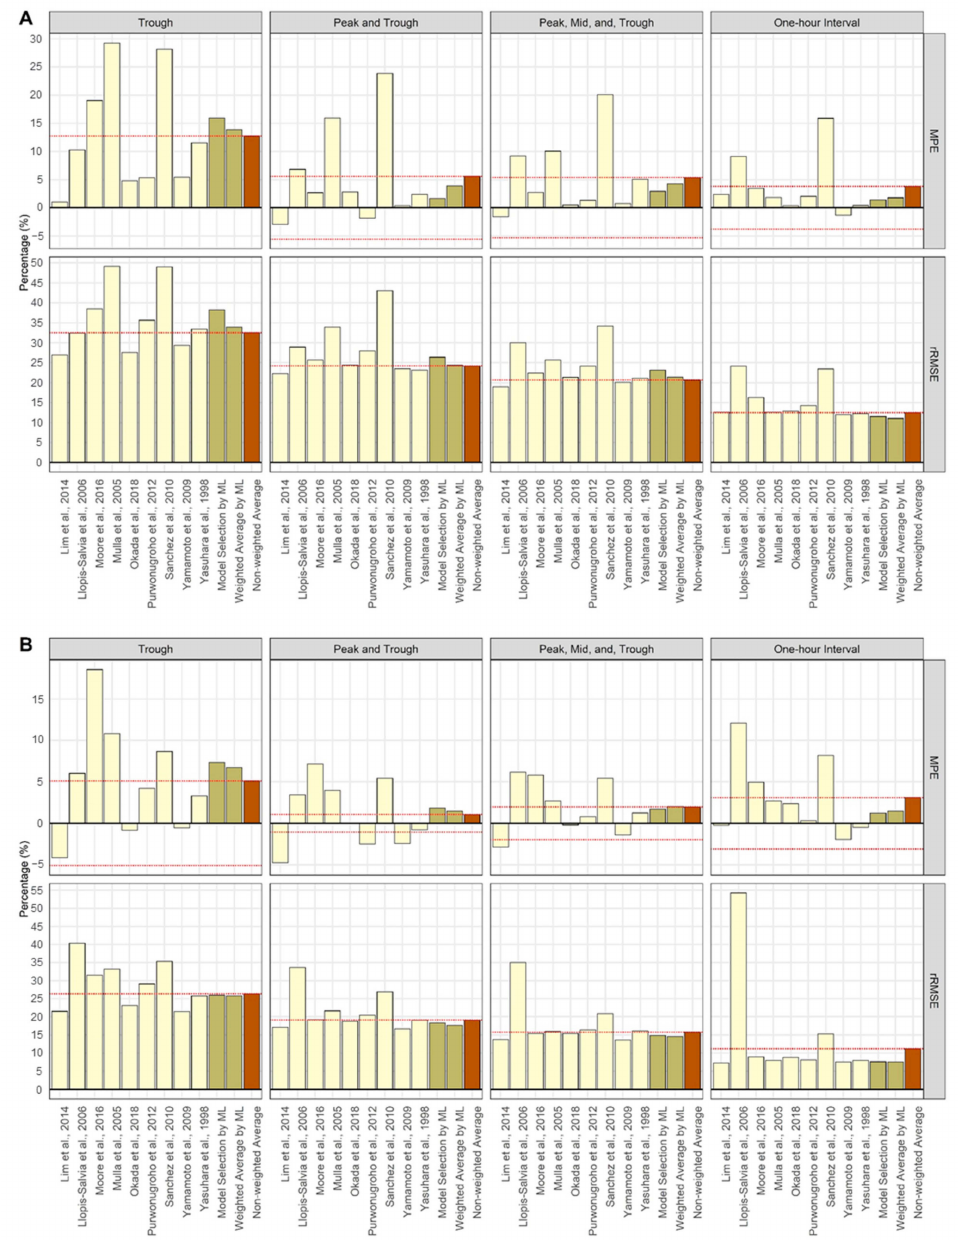
Figure 4. The mean percent error ( MPE ) and relative root mean squared error ( rRMSE ) of the predicted AUCs relative to the true AUCs of each simulation scenario for external validation [19–27]. The prediction method (using a single model, ML application, and comparison) is distinguished by yellow, olive, and brown colors, respectively. The red dashed horizontal line is the value obtained using the non-weighted average method. ( A ) Single dose; ( B )